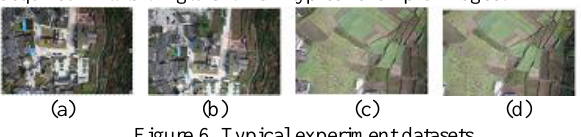
Figure 6. Typical experiment